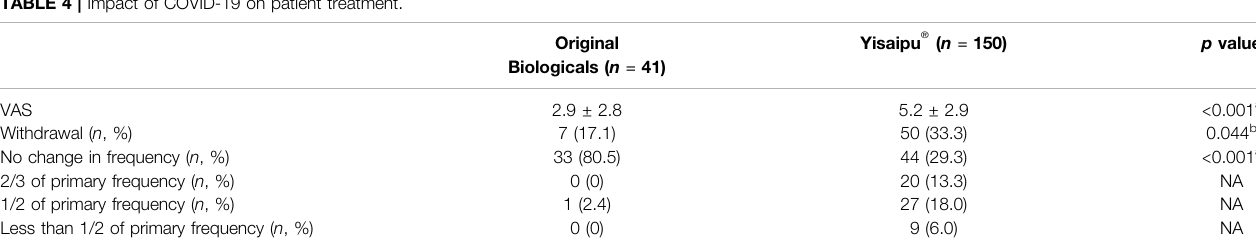
TABLE 4 | Impact of COVID-19 on patient